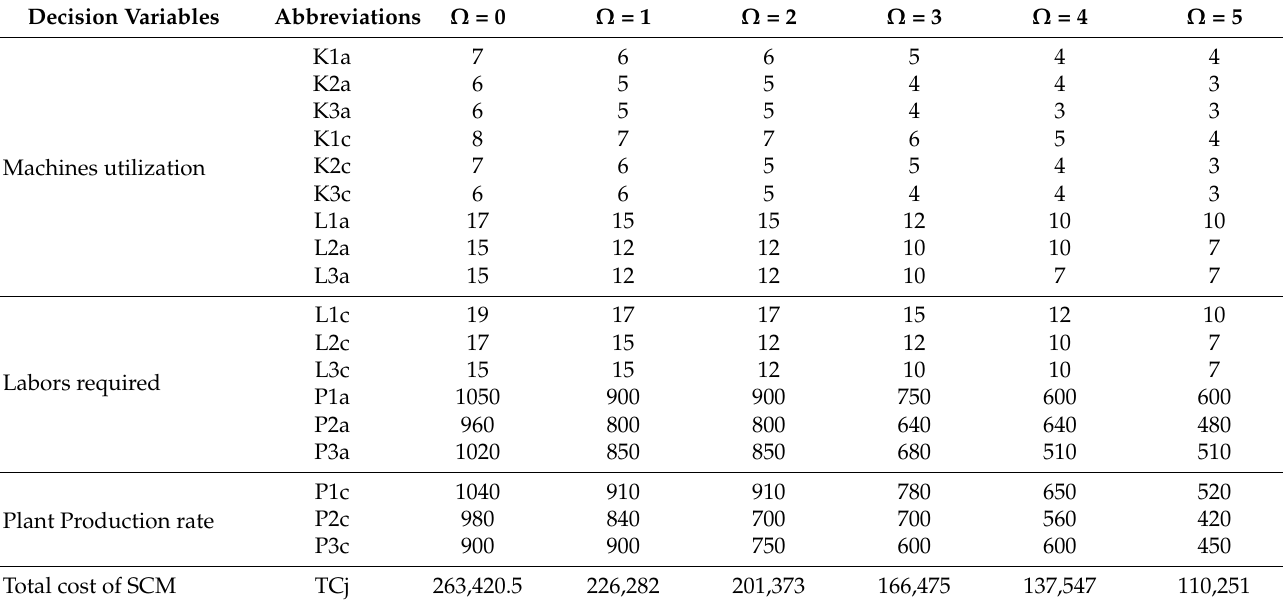
Table 6. The utilization of resources with respect to the emergency levels ( Ω ) due to COVID-19 pandemic. Decision Variables